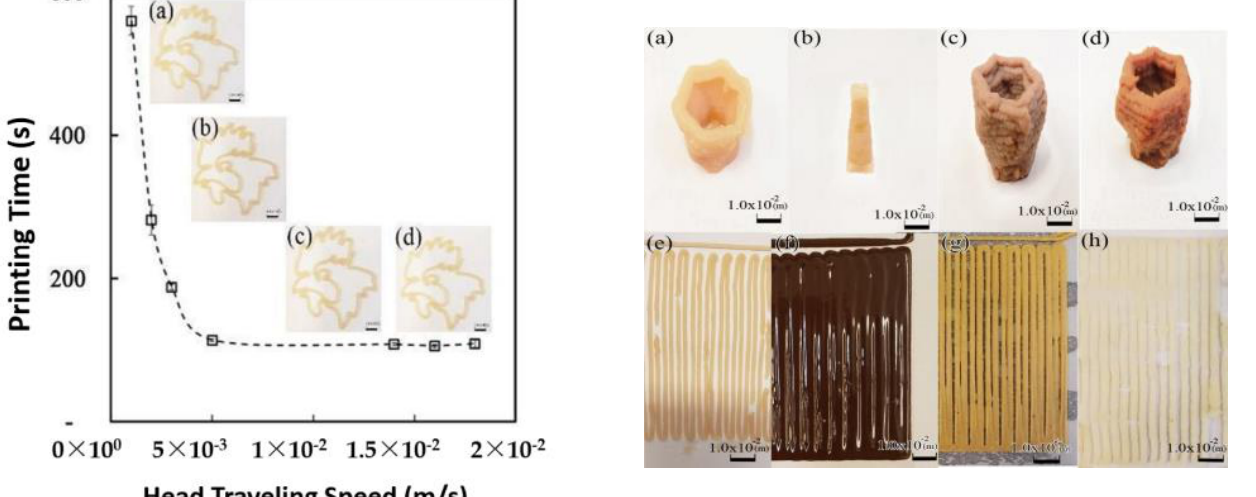
Figure 8. ( Left ) : The accuracy of 2.5D printed images as printing time reduces with the increase in head traveling speed. ( a ) Head traveling speed: 1.0 × 10 −3 m/s; ( b ): head traveling speed: 5.0 × 10 −3